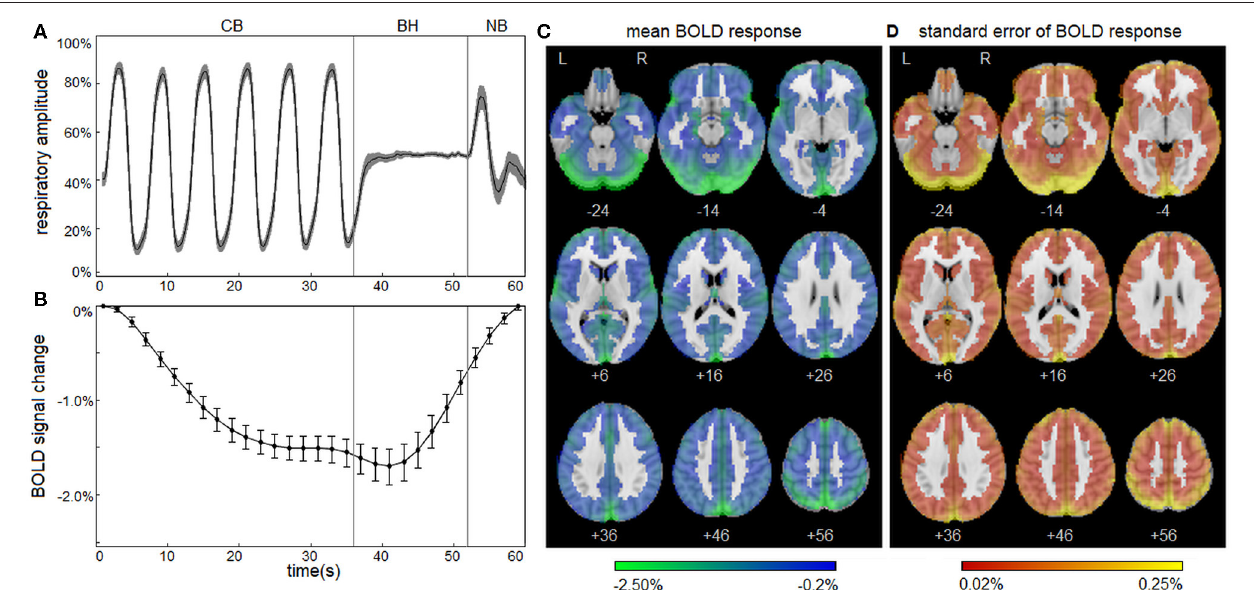
FIGURE 1 | Blood-oxygenation-level-dependent (BOLD) response to the respiratory task for control athletes. (A) The group average of the mean respiratory trace, normalized to the range of 0–1 and downsampled to intervals of 0.20s. (B) The group average of the mean BOLD temporal response x t . Shaded areas and error bars denote the bootstrapped 95% confidence intervals of the mean. (C) The group average of the mean BOLD spatial response x s . (D) The standard error of the group average x s . Plots depict a highly consistent respiratory trace and BOLD response to the task for athletic